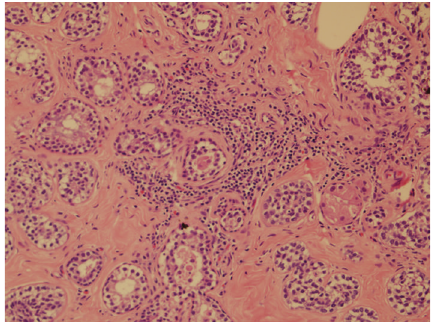
Figure1:Hookwirelocalisedexcisionbiopsyshowedbothepithelial